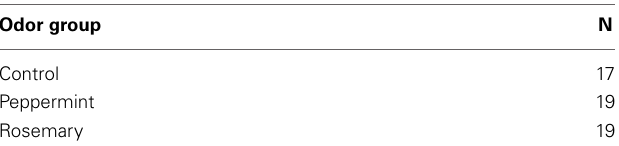
Table 1 | Sample size experimental